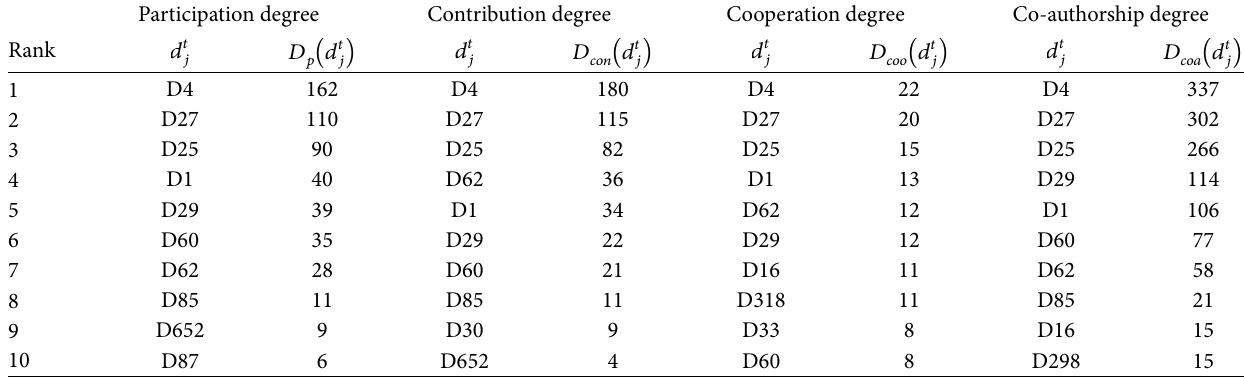
10: The top ten drafters with high indicators in CDMA2000